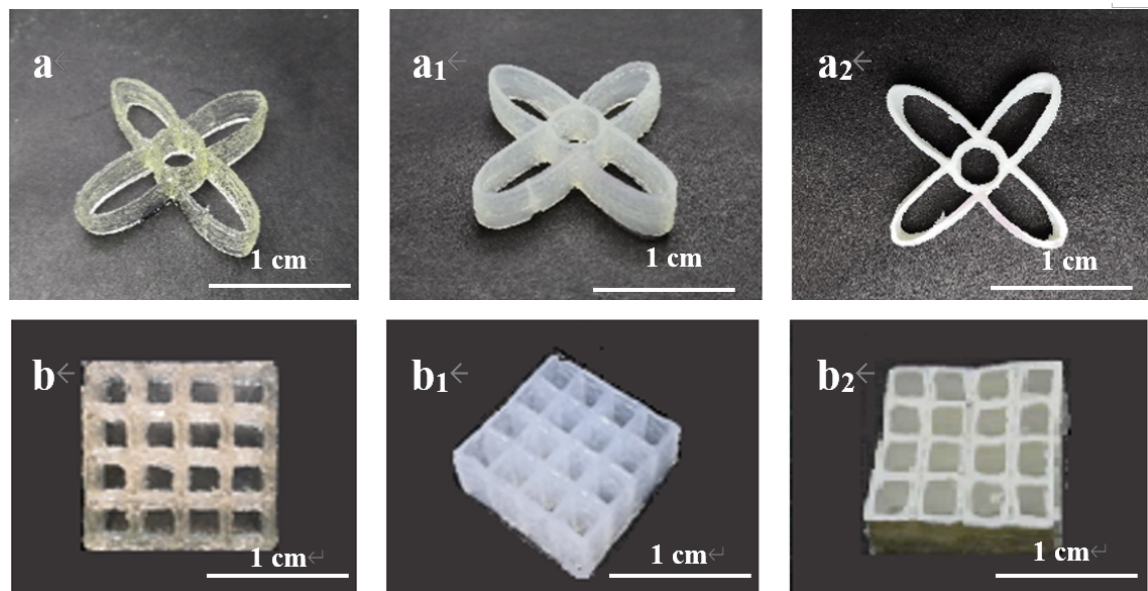
Figure 3: The digital pictures of the 3D printed cellulose scaffolds: a, b – as-printed samples; a 1 , b 1 – the hydrogel scaffolds; a 2 , b 2 – the freeze-dried samples